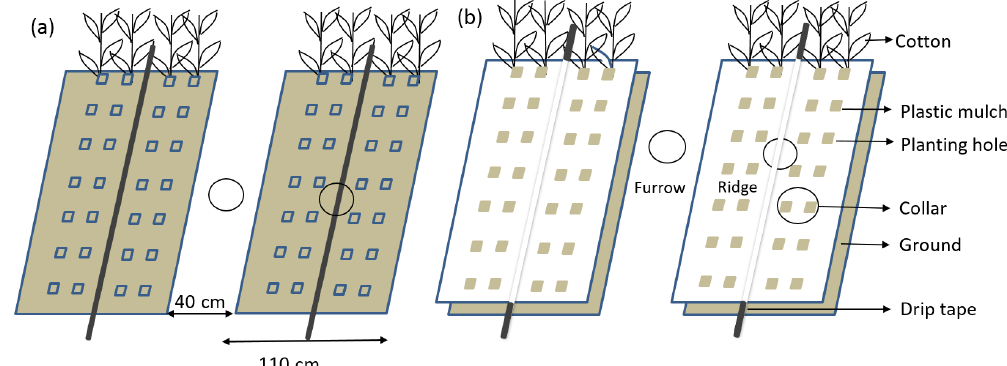
Figure 1. Schematic drawing of the experimental configuration for (a) a non-mulched field and (b) a mulched field.